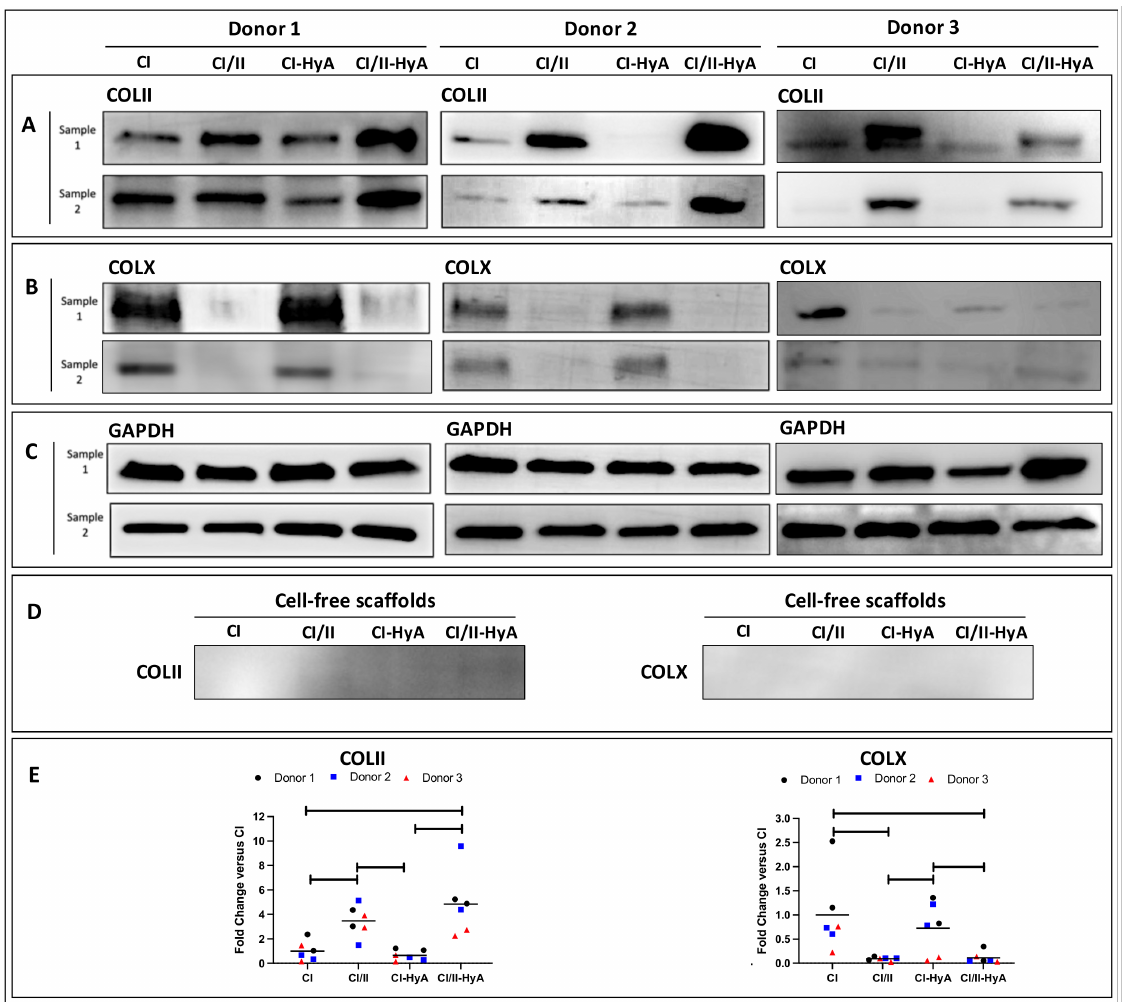
Figure 8. The incorporation of CII was associated with a reduction of COLX synthesis, and in combination with HyA, was found to increase the accumulation of COLII in the matrices by day 28. The expression of COLII ( A ), COLX ( B ) and GAPDH (housekeeper) ( C ) proteins was determined for scaffolds seeded with human MSCs from donors 1, donor 2 and donor 3 after 28 days in culture. COLII and COLX protein expression was also determined on cell-free scaffolds ( D ). The relative protein-band intensity of COLII and COLX was quantified and normalised to GAPDH ( E